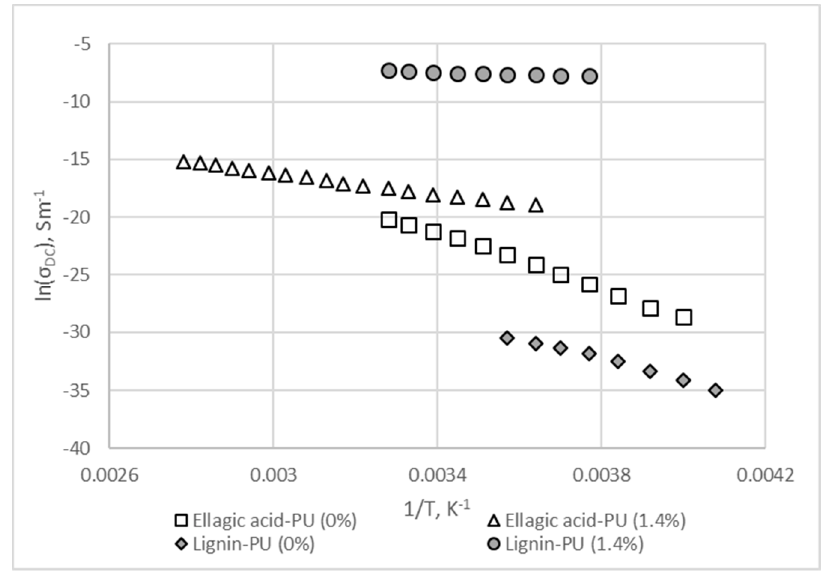
Figure 2. Logarithm of DC conductivity ( σ DC ) versus the inverse of the temperature for LignoBoost ® kraft lignin and ellagic acid based polyurethane polymer composites. Ellagic acid-based polyurethanes had low conductivity even after doping with 1.4% (w / w)